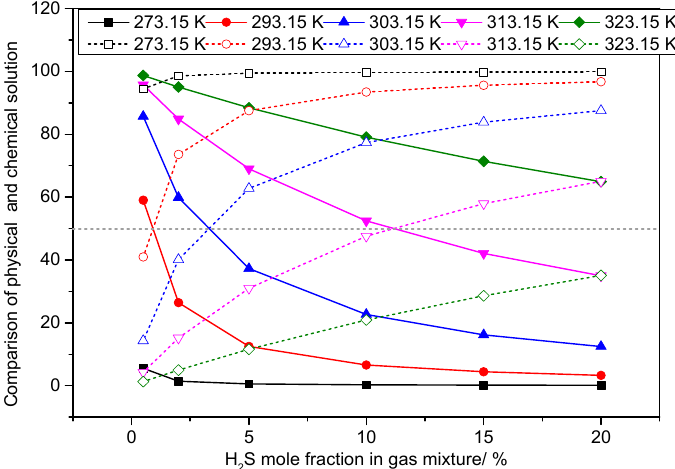
Figure 16. Variation curve of physical and chemical solubility ratios under the same conditions.